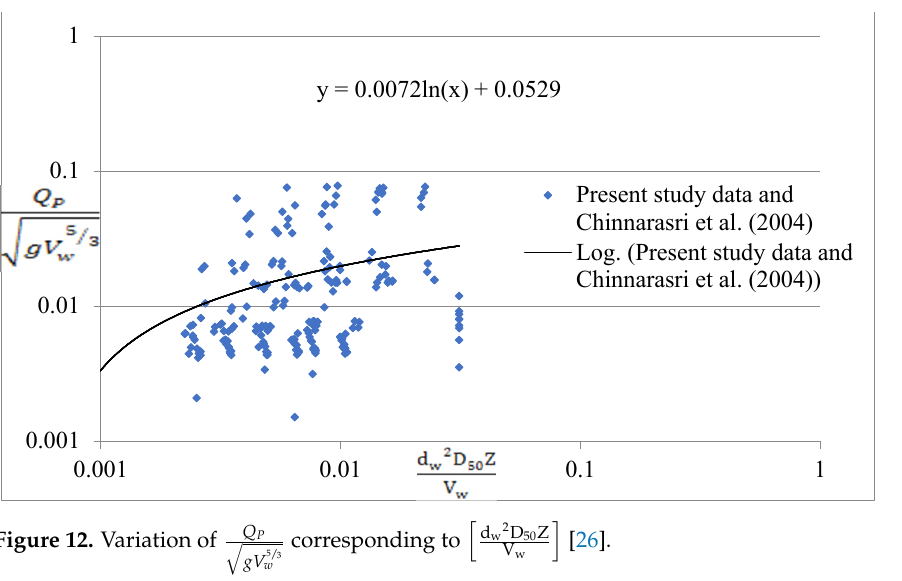
Figure 12. Variation of Q P (cid:113)